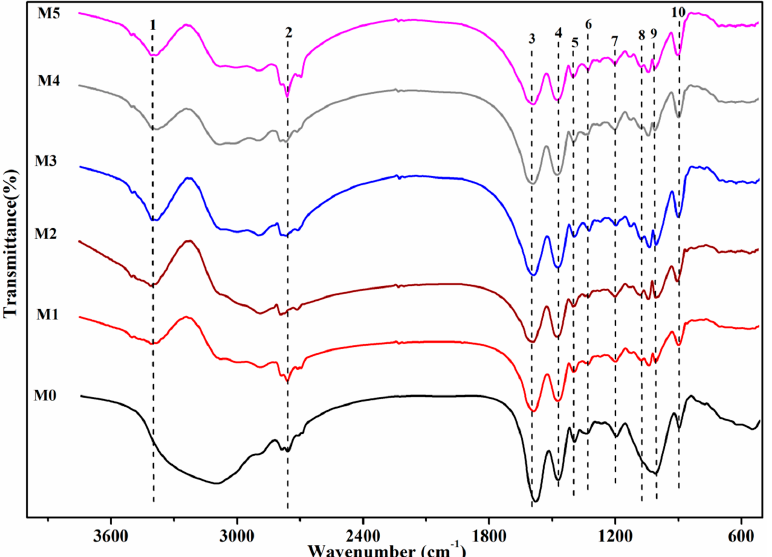
Figure 4. FTIR spectra of the raw and modified Deinococcus radiodurans after biosorption of uranium ( C 0 U(VI) = 50 mg·L − 1 (dry biomass) = 0.25 g·L − 1 , pH = 5.0, temperature = 35 °C, t = 3 h). M0, unmodified